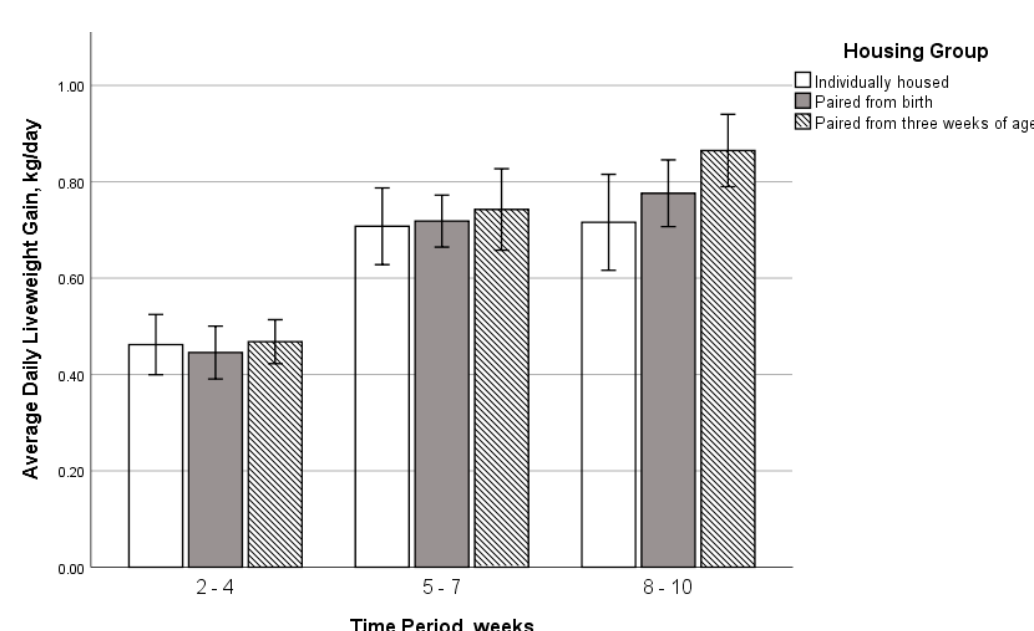
Figure 3. ADLG (kg/day) over the different time periods for the three different housing groups, with the 95% confidence interval. Calf numbers for each group include individually housed calves ( n = 19 calves), calves paired at birth ( n = 40 calves), and calves paired at three weeks of age ( n = 38 calves). All calves were housed in groups of five during weaning (weeks 8–10).